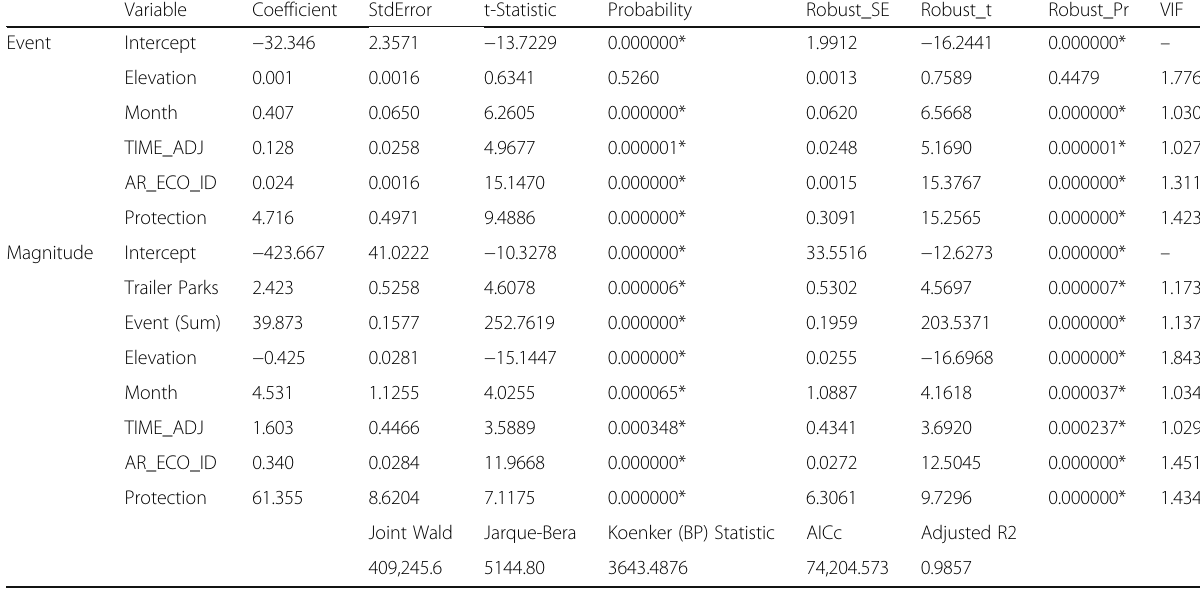
Table 2 Ordinary Least Square results for